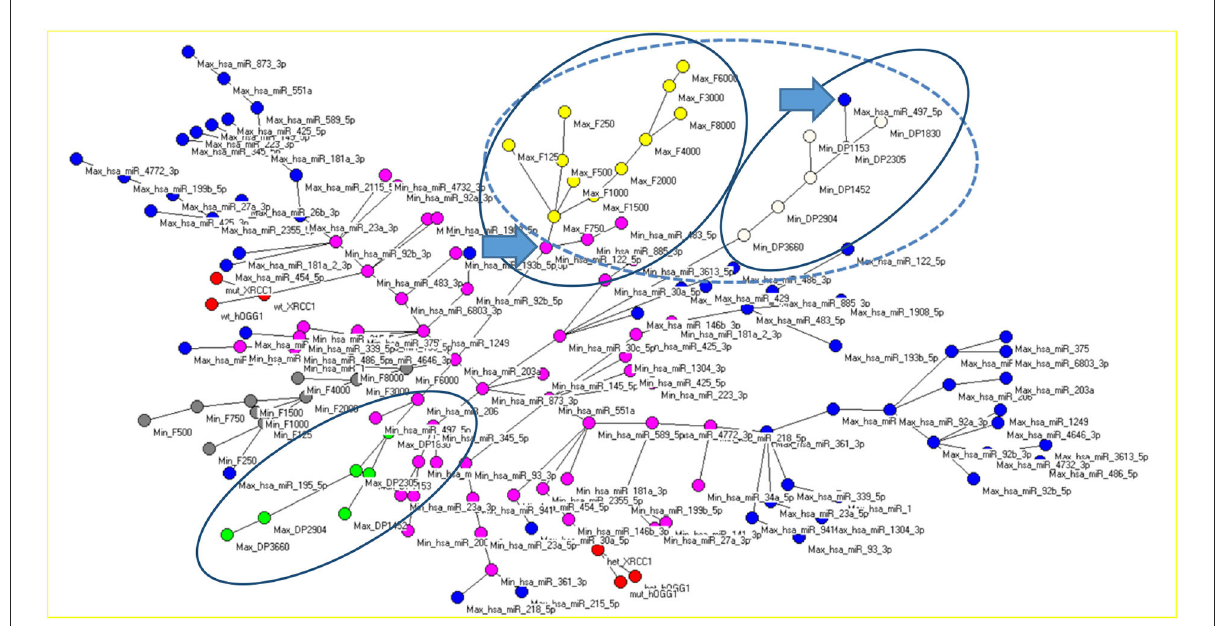
FIGURE5 MST Graph, visually representing the most relevant connections between all the considered variables, microRNA (blue and pink circles, respectively, for the normalized variable and its complement to unity), HL (yellow and gray circles), DPOAE (green and white circles), and polymorphisms (red circles). The ellipses encircle branches of audiological variables correlated to each other. The blue arrows point to microRNAs that are strongly associated with specific branches of the audiological variables. The dashed-line ellipse highlights the negative correlation between HL and DPOAE